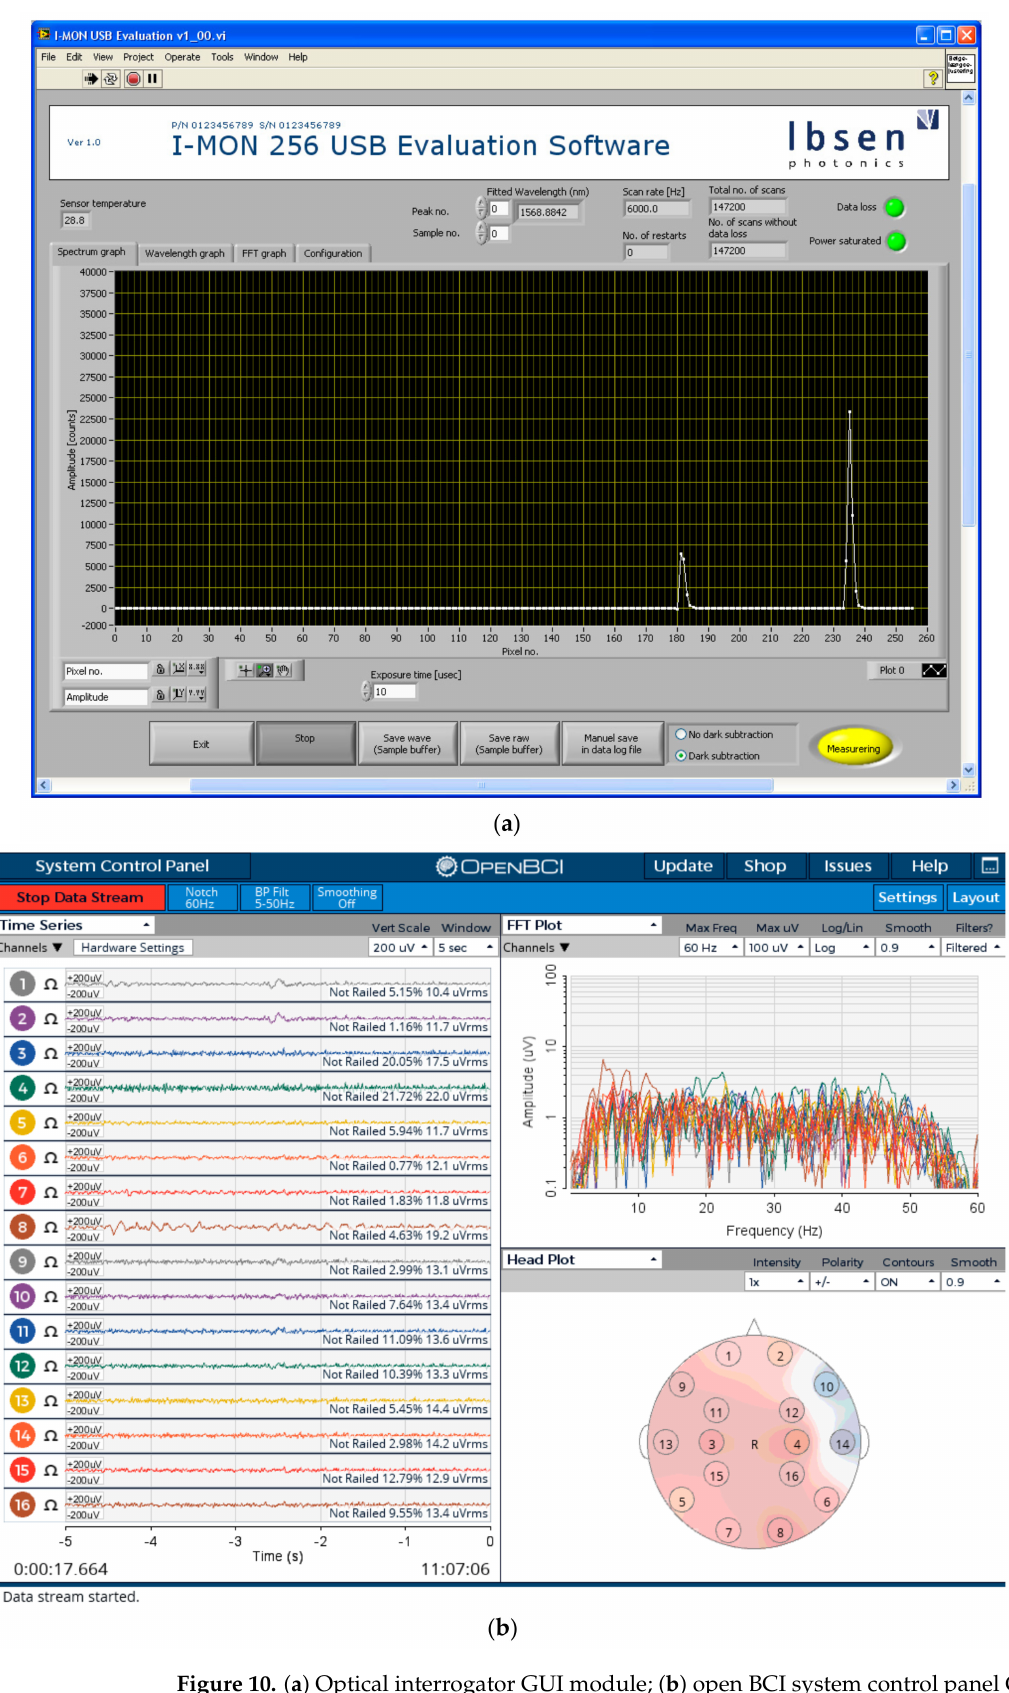
Figure 10. ( a ) Optical interrogator GUI module; ( b ) open BCI system control panel GUI 16 channel